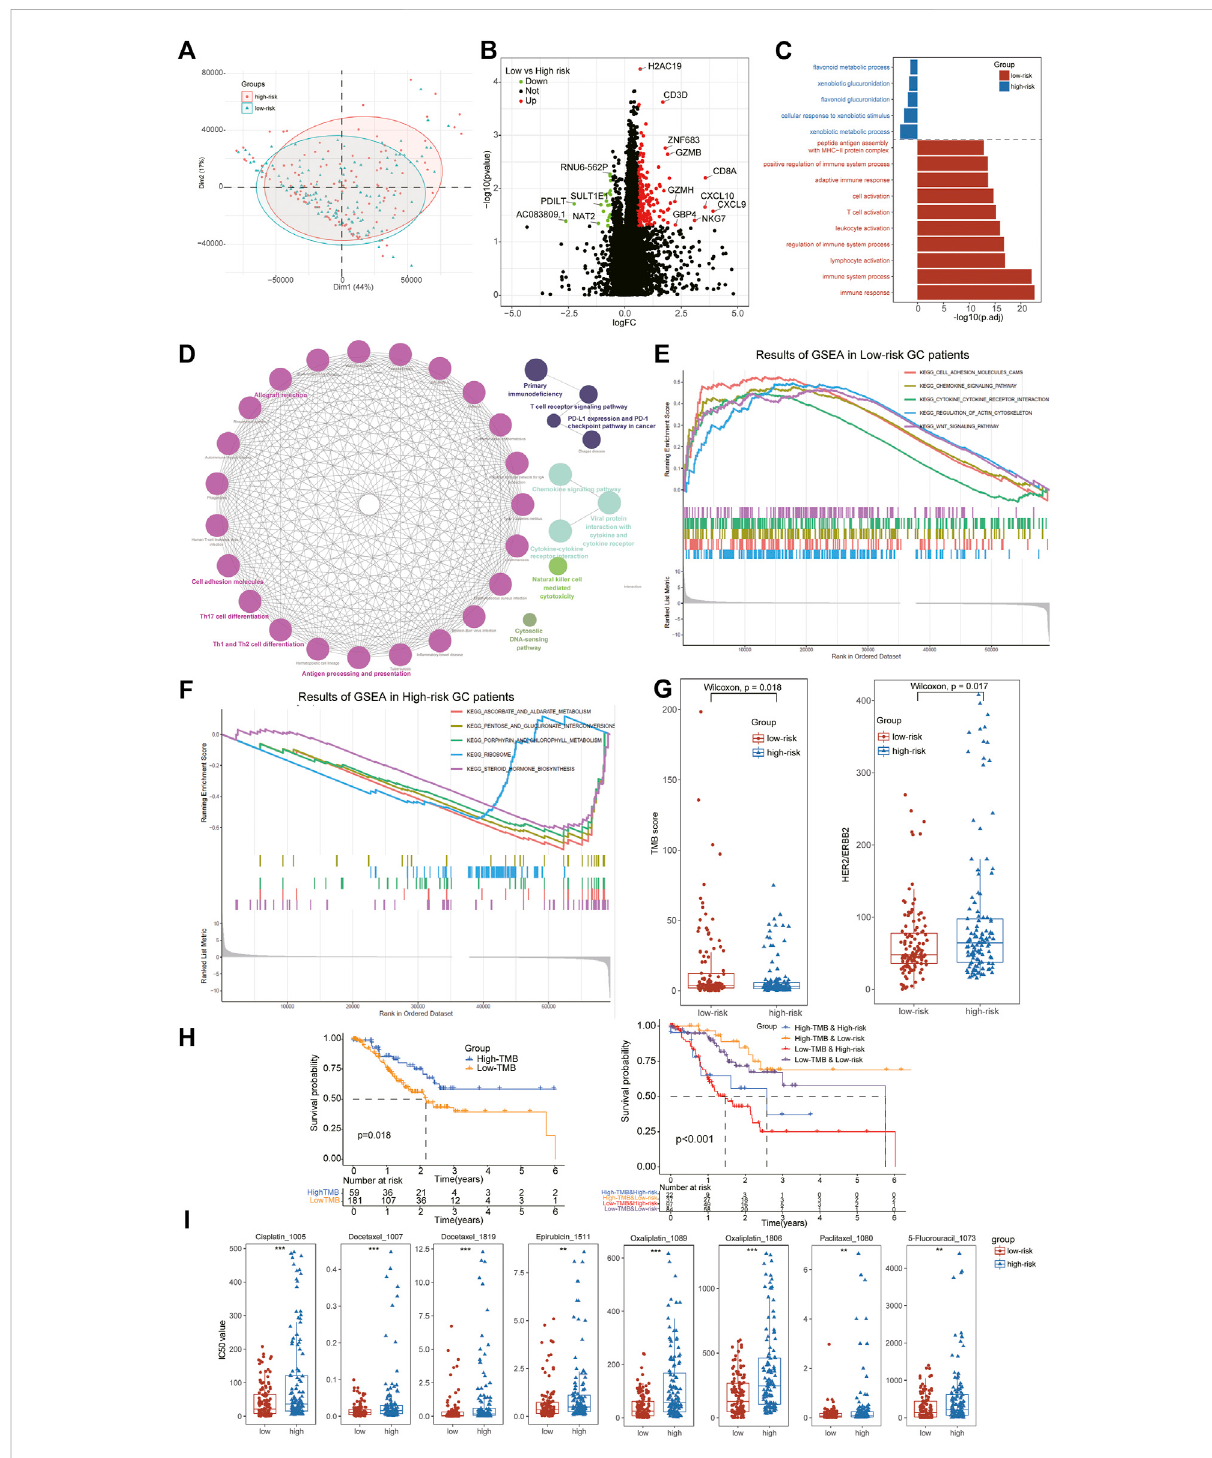
FIGURE 6 Identi fi cation of DEGs between subtypes and Evaluation of therapeutical susceptibility in STAD. (A) The PCA analysis showing signi fi cant differences in the RNA-seq transcription pro fi les between two ATIRE-Risk score related subgroups. (B) A total of 211 DEGs were identi fi ed including 189 DEGs for low-risk and 21 DEGs for high-risk patients. (C) Go enrichment analysis indicated that the low-risk DEGs were enriched in immune activation-related biological processes while the high-risk DEGs were enriched in metabolism-related biological processes. (D) The results of KEGG analysis found immune activation status of low-risk patients. (E,F) GSEA demonstrated the activation of above immune-related pathways in low-risk patients and metabolism-related pathways in high-risk patients. (G) The low-risk patients exhibited higher levels of TMB scores and lower expression of HER2, an index for targeted therapy in STAD patients. (H) The strati fi ed survival analysis further indicated patients with low-risk and high-TMB scores exhibited the best prognosis outcomes. (I) All the anti-STAD chemotherapeutic drugs (including Cisplatin,